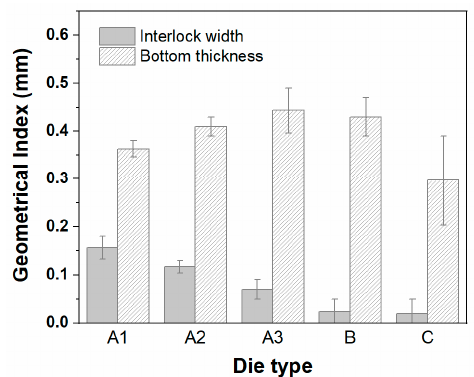
Figure 7. Geometrical indices for SPR joint of vibration-damping steel (top) and Al5052-H32 (bottom) with respect to SPR die with respect to SPR die type.